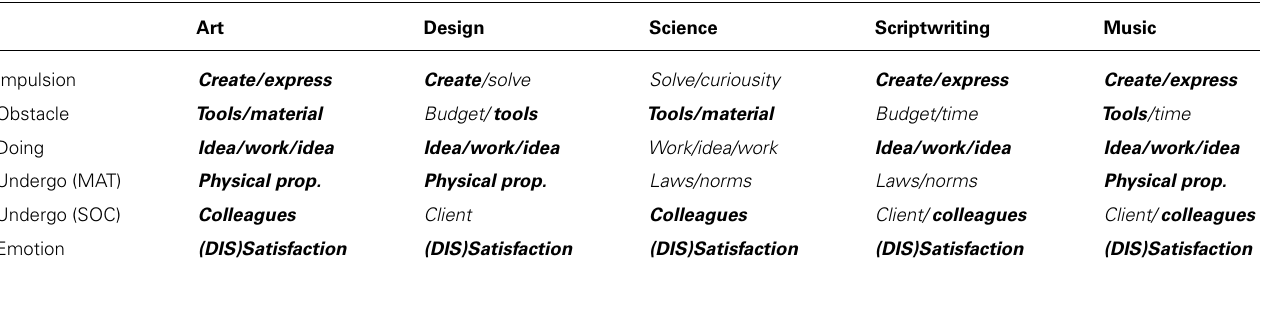
Table 3 | Summary of patterns in creative activity in the five domains.